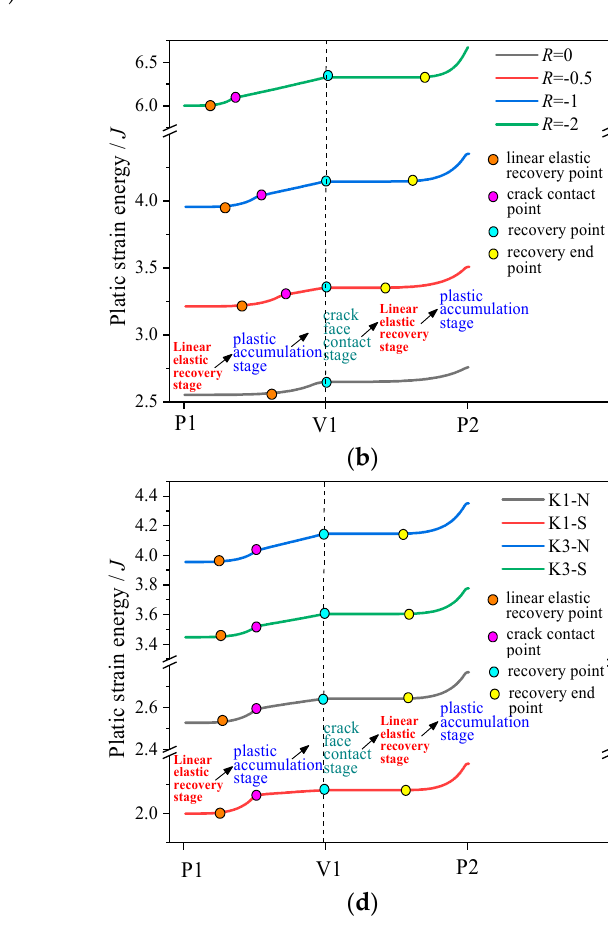
Figure 16. Elastic and Plastic strain energy: ( a ) effect of R on elastic strain energy; ( b ) effect of R on plastic strain energy; ( c ) effect of specimen type on elastic strain energy; ( d ) effect of specimen type on plastic strain energy.